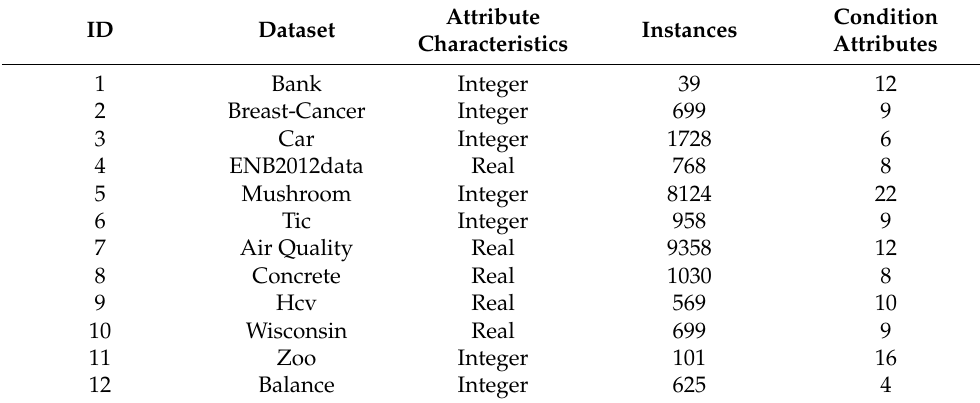
Table 5. The description of